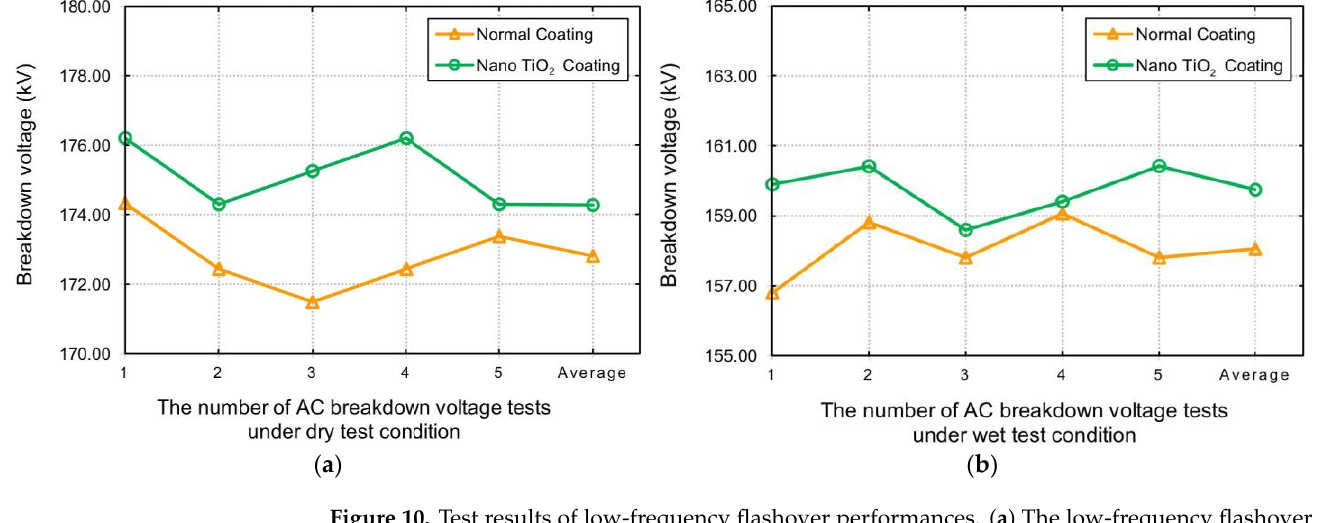
Figure 10. Test results of low-frequency flashover performances. ( a ) The low-frequency flashover performances under dry test condition; ( b ) The low-frequency flashover performances under wet test